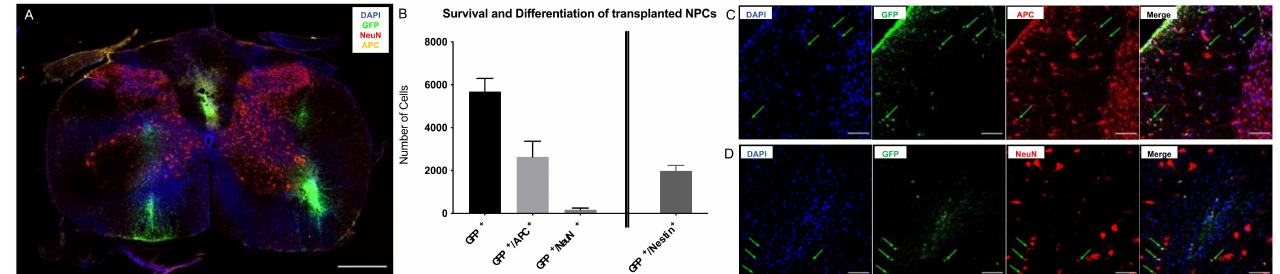
Figure 1. Survival and differentiation of transplanted NPCs eight weeks after severe cervical SCI. ( A ) Representative image of an NPC animal spinal cord cross-section at 10 × magnification depicting the spatial distribution of transplanted NPCs (GFP + /DAPI + ), NPC-derived neurons (GFP + /DAPI + /NeuN + ) and NPC-derived oligodendrocytes (GFP + /DAPI + /APC + ; scale bar = 500 µ m). ( B ) Mean number of surviving NPCs (GFP + ), NPC-derived mature neurons (GFP + /NeuN + ), NPC- derived mature oligodendrocytes (GFP + /APC + ) and undifferentiated NPCs (GFP + /Nestin + ) in the injured spinal cord of animals in the NPC group (group 1; n = 8 animals). ( C ) Colocalization (green arrows) of DAPI, GFP and APC, indicating surviving, viable and mature NPC-derived oligodendrocytes and of ( D ) DAPI, GFP and NeuN, indicating surviving, viable and mature NPC-derived neurons in an NPC animal at 40 × magnification (scale bar = 100 µ